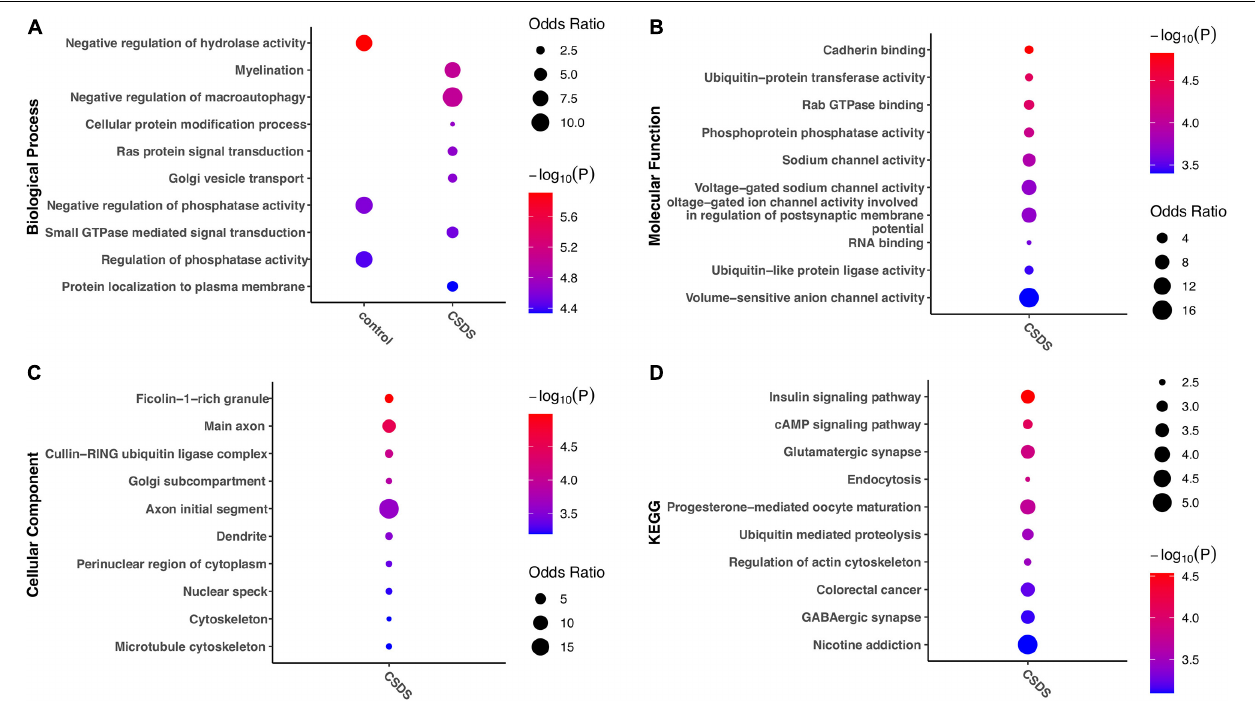
FIGURE 5 | Gene ontology and KEGG pathways erniched in gene with CSDS-associated G-to-A RNA editing. The items with the most significant P -values are shown for (A) biological processes, (B) molecular functions, and (C) cellular components, as well as (D) KEGG pathways enriched in either CSDS or controls. CSDS, chronic social defeat stress.